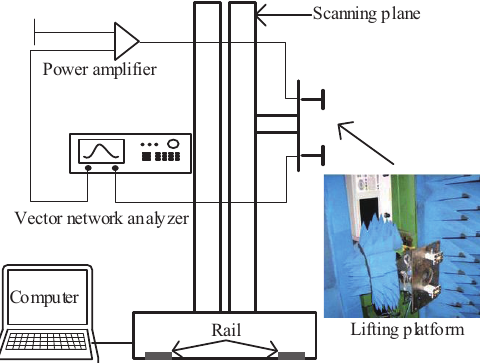
Figure 9. Anechoic chamber test